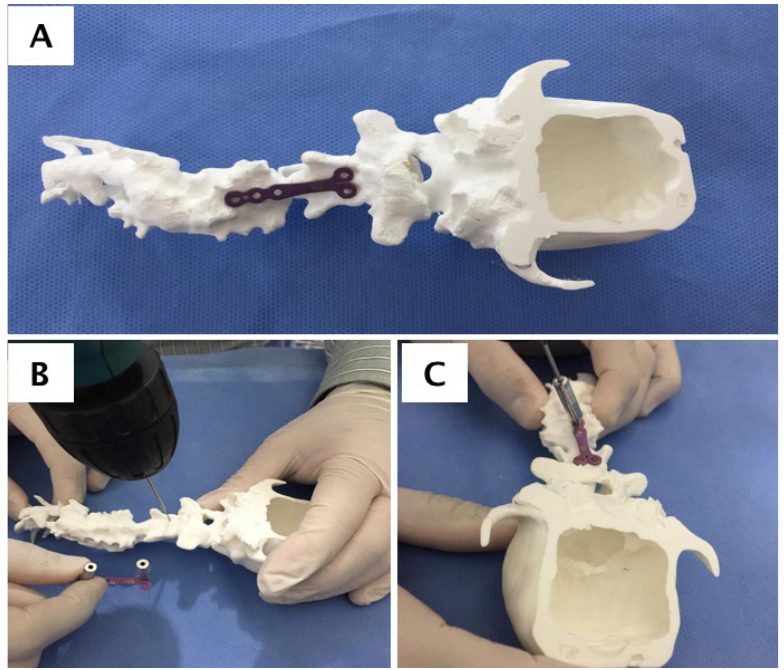
Figure 5. 3D prosthesis printed in PLA (polylactic acid) of the cranio-cervico-thoracic region of the 3-month-old male MBD dog with congenital vertebral malformations. The 3D prosthesis covered from the craniocervical junction to the first thoracic vertebrae and was used for the surgical planning of cervical stabilization. The prosthesis was decisive for better positioning of the patient on the table, surgical access, type and size of the implants and the location to fix the implant on the cervical vertebrae. (Veterinary Hospital/UFRRJ – August/2019) Note. A) Choice of ventral access and implant (1.2mm “T” titanium plate with 5 holes) suitable for the patient using the 3D prosthesis. B) Planning of implant fixation between C2 and the block vertebrae using the 3D prosthesis. C) Fixation of the implants and choice of